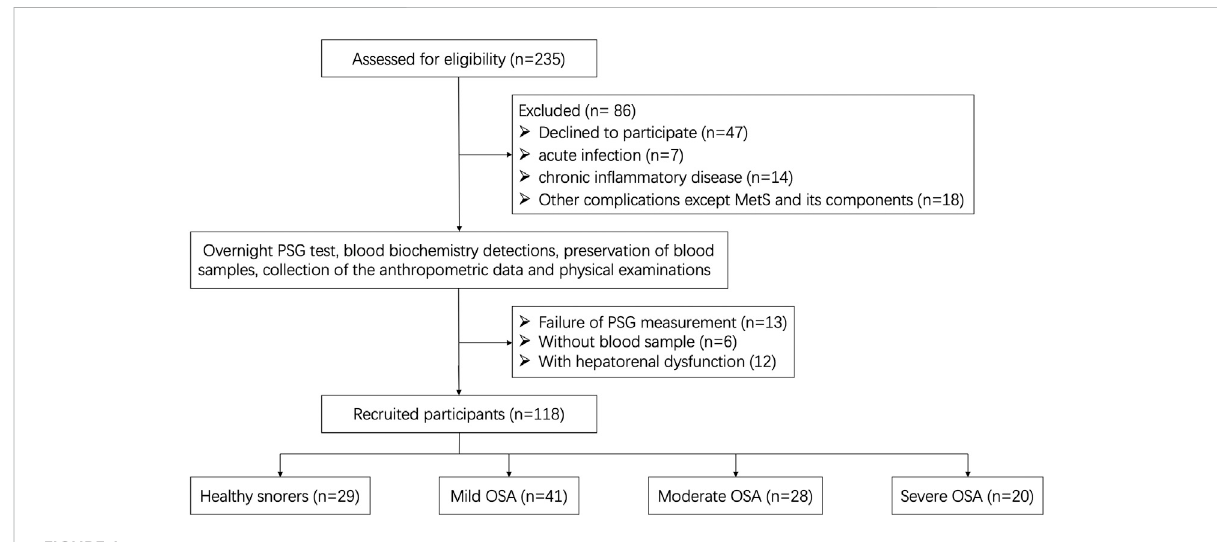
FIGURE 1 Flowchart of data generation and